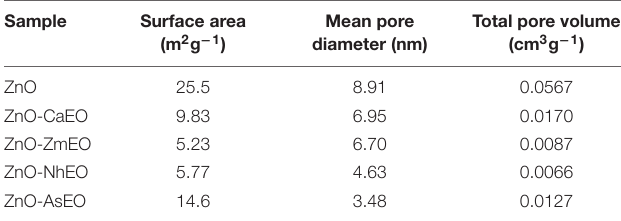
TABLE 2 | Textural characteristics of the ZnO and ZnO-EOs materials. Sample